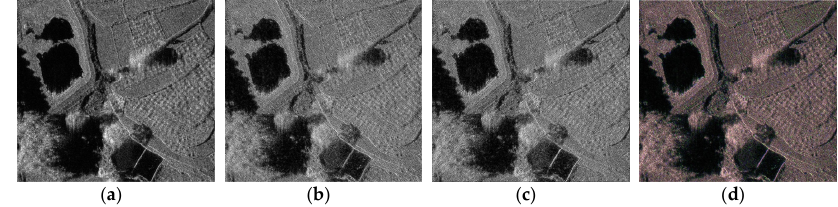
Figure 8. Gabor transformation results. ( a ) SAR image. ( b ) Gabor transformation of 45-degree. ( c ) Gabor transformation of 135-degree. ( d ) the concatenation results of Gabor transformation.